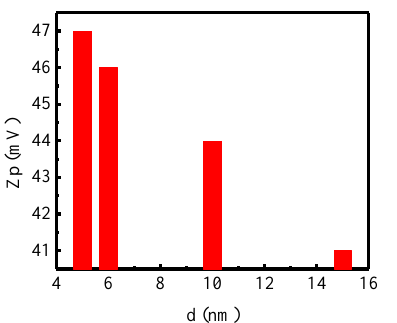
Figure 10. Zeta potential of CS-coated MnFe 2 O 4 nanoparticles for 5 nm, 6 nm, 10 nm, and 15 nm at room temperature during the DLS measurement.